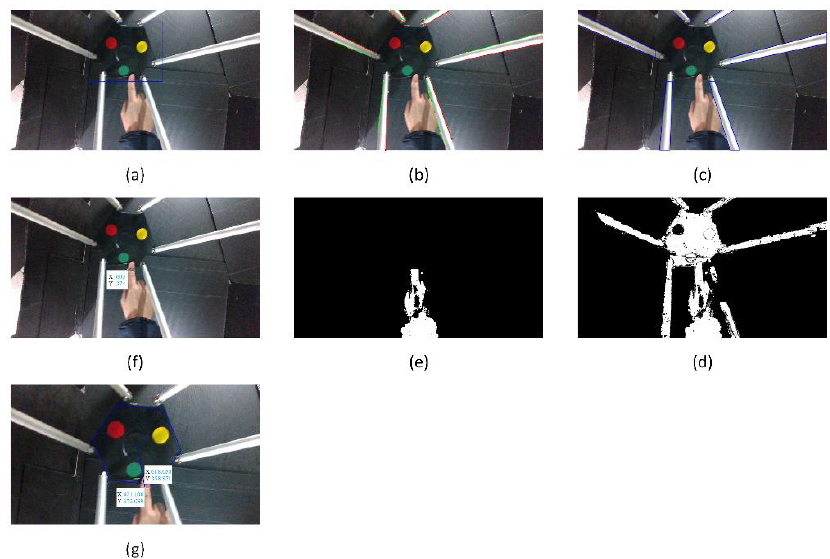
Figure 12. The collision isolation procedure in Case 1: ( a ) The bounding box around the active plate; ( b ) straight lines around rods; ( c ) recognized rods; ( d ) objects in the workspace; ( e ) the external object; ( f ) intersections of the external object and the bounding box; ( g ) the contact point.